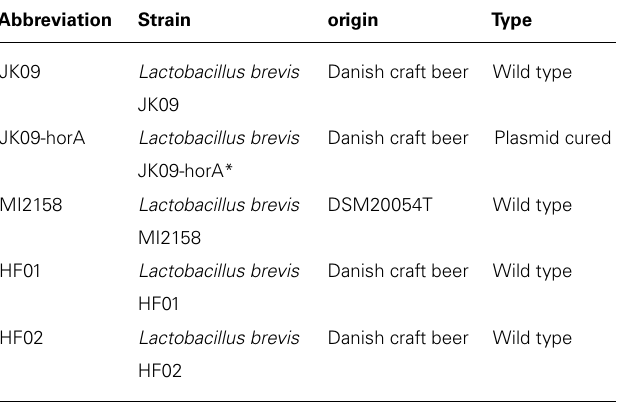
Table 1 | Overview of the strains used in this